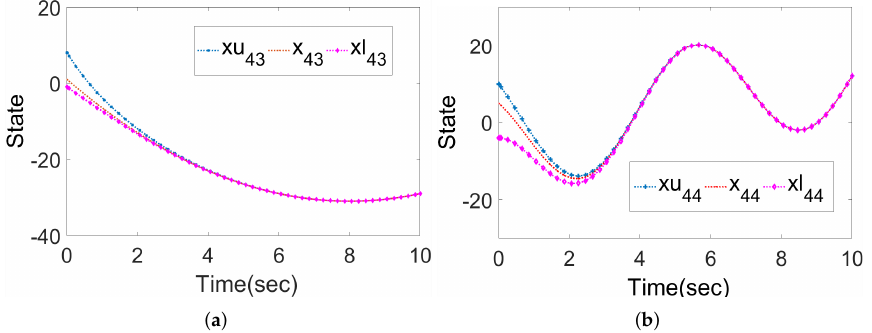
Figure 4. Evolutions of velocity of original system and DIO at the first joint ( a ) and second joint ( b ) of fouth manipulator.